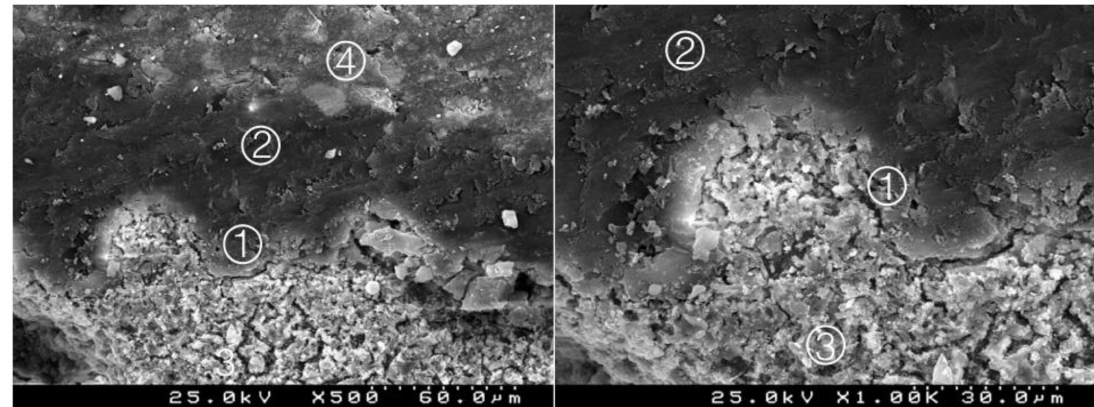
Figure 13. Group 11 (NeoMTASE1I): hybrid layer 1 (cid:13) with evident interpenetration between the adhesive 2 (cid:13) and the NuSmile ® NeoMTA 3 (cid:13) . Composite resin 4 (cid:13) (original magnification 500 × and 1000 × ).